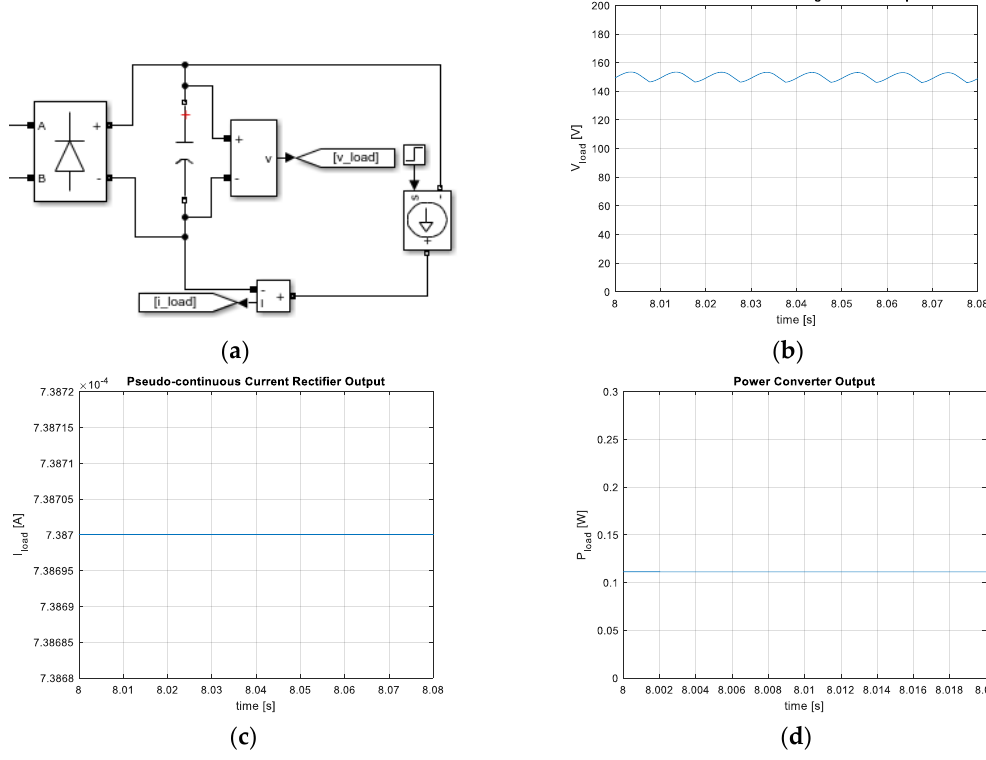
Figure 10. Single-phase rectifier circuit ( a ), rectifier output voltage ( b ), rectifier output current ( c ) and output power ( d ).